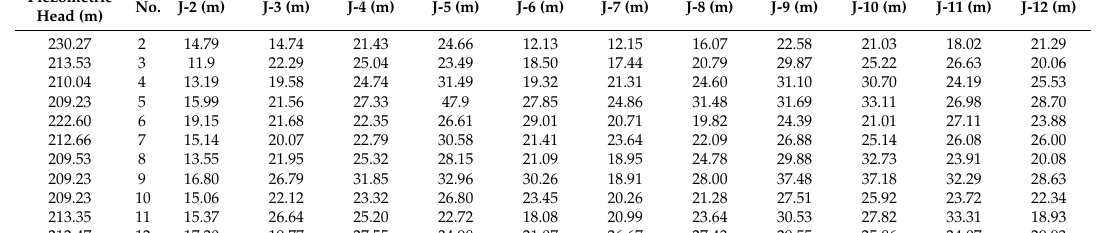
Table 7. Pressure change at each junction due to a sudden change in demand.